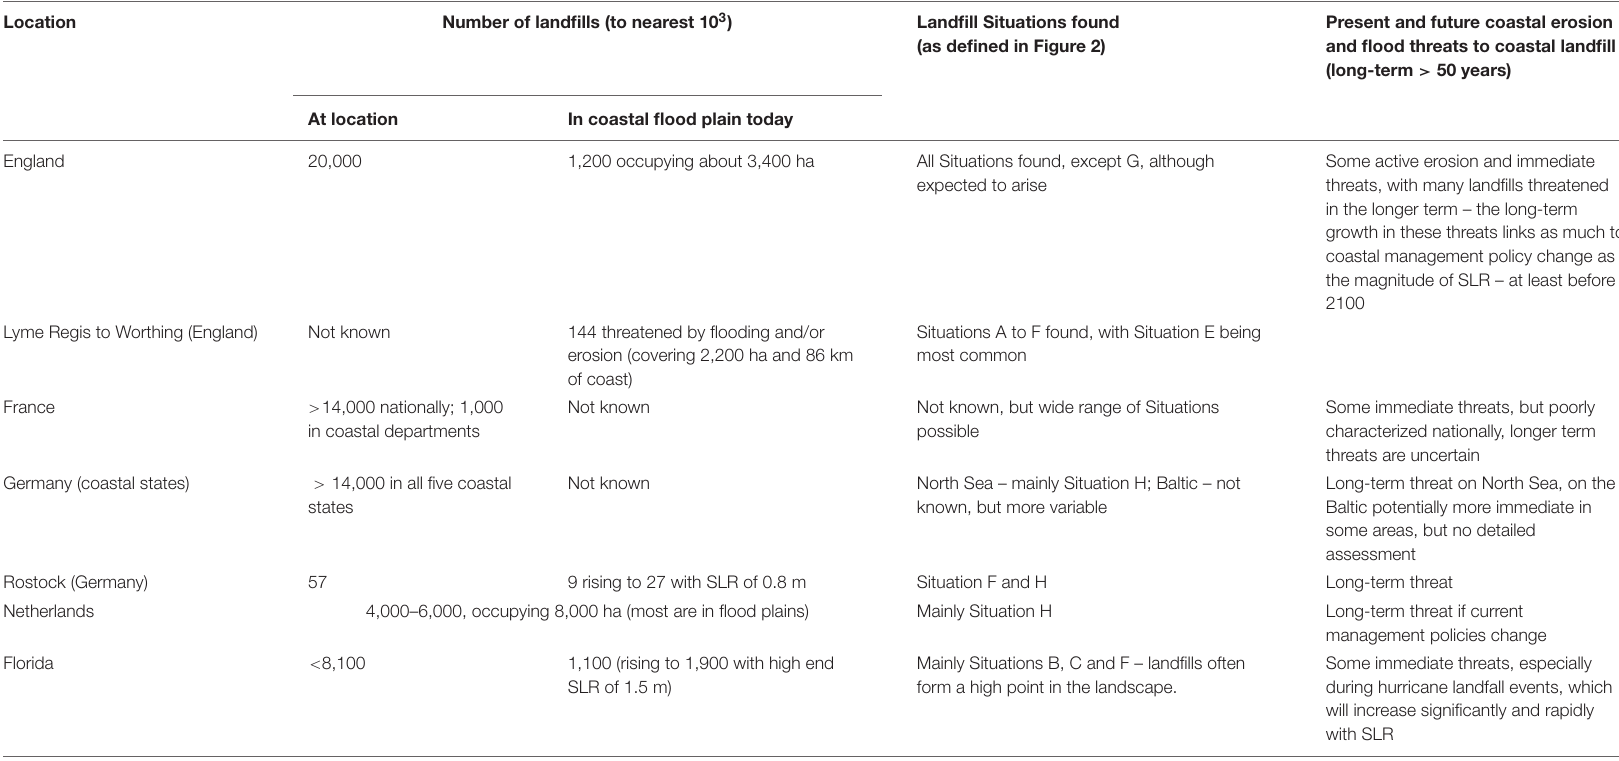
TABLE 4 | Synthesis of the case study